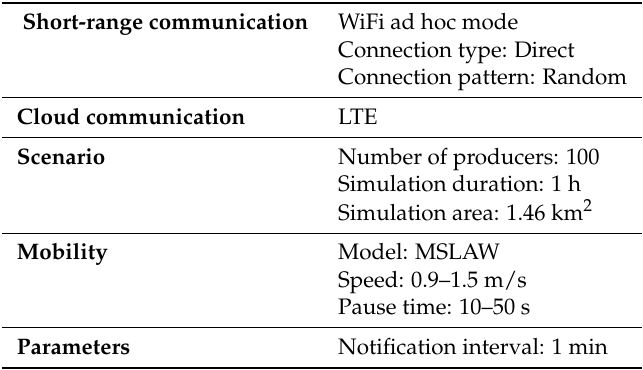
Table 1. Shared simulation